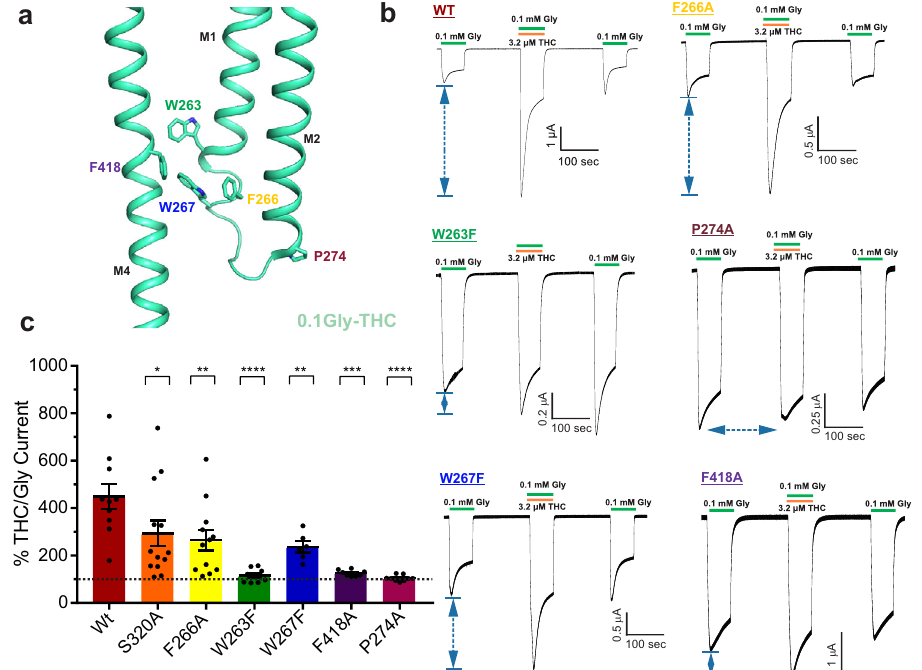
Fig. 6 | Mutational analysis of THC-binding pocket. a Residues lining the THC- binding pocket and along the putative coupling pathway. b Representative TEVC recordings of GlyR WT and mutants activated by 0.1mM glycine, and with co- application of 3.2 μ M THC. Membrane potential was held at − 60mV. c Percent potentiationisplottedas(peakofTHC-glycinecurrent/peakglycinecurrent)x100 for WT ( n =10), S320A ( n =13) W263F ( n =9), F266A ( n =12), W267F ( n =6), P274A